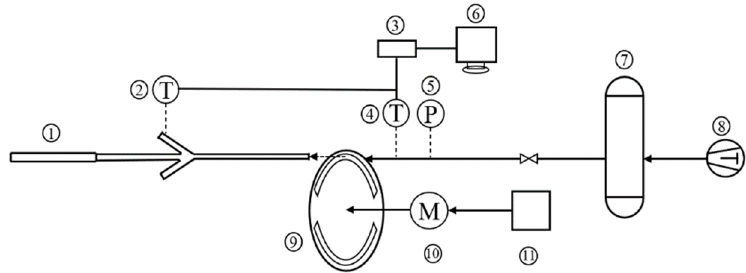
Figure 12. Schematic diagram of the experimental process. 1—gas wave tube; 2,4—temperature sen-